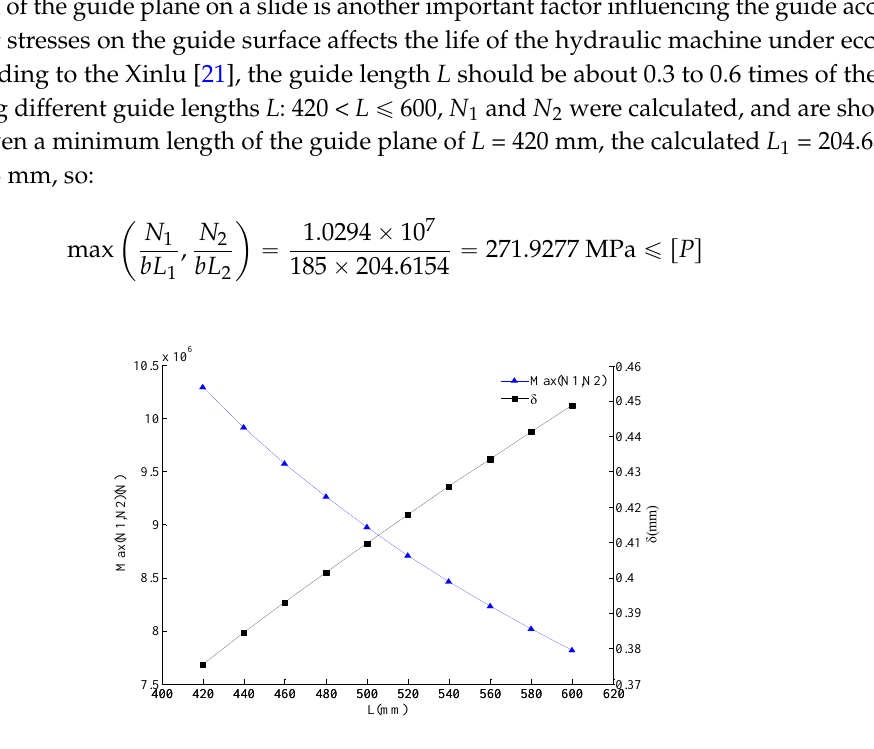
Figure 9. Max ( N 1 , N 2 ) and the fit clearances δ calculated according to different L in the range of (420,600).